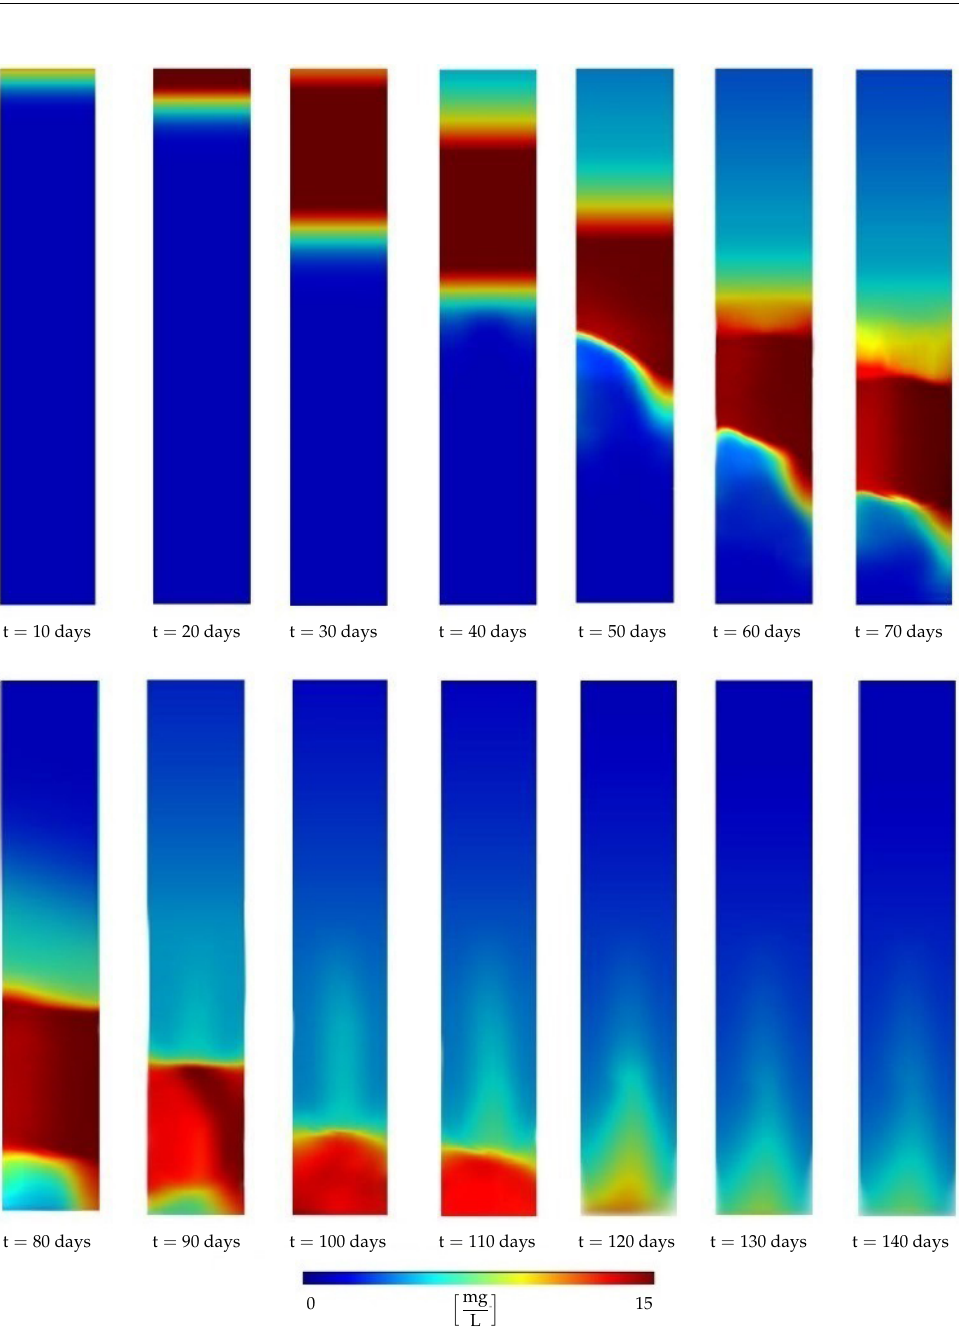
Figure 6. Contaminant concentration